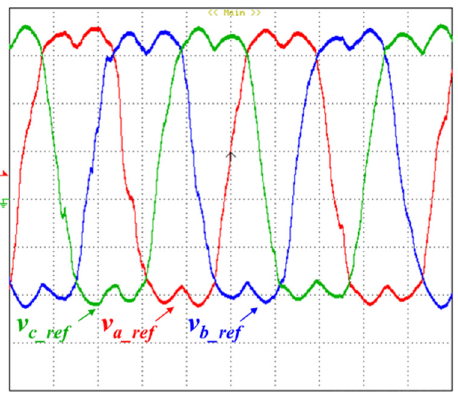
Figure 29. Reference signal and current in phase a when the electric machine operates with a 9 Nm mechanical load (current: 50 A/div; voltage: 5 V/div; time: 5 ms/div).